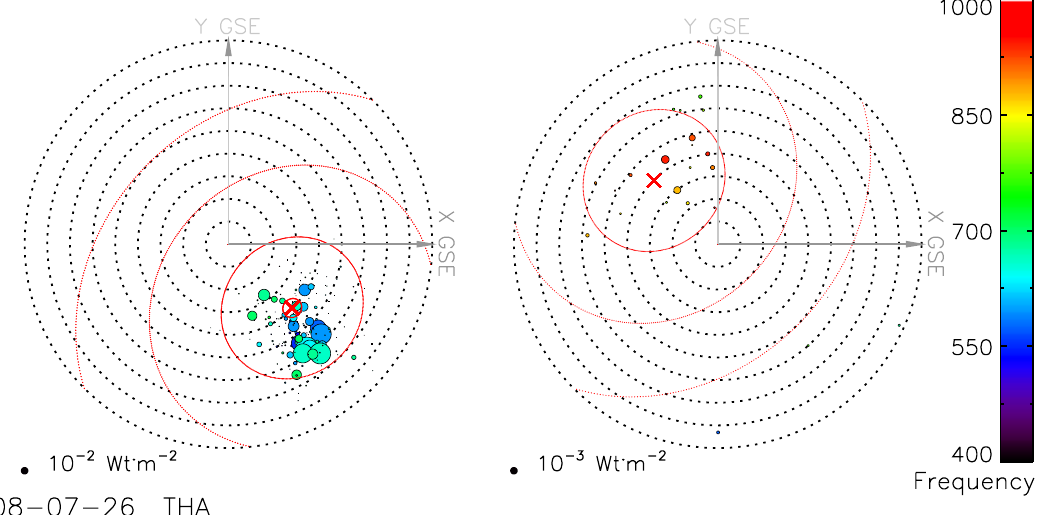
Fig. 4. The Poynting vector directions of the wave packets. The Sun is to the right, and the polar axis is along Z GSM . The background magnetic field direction is indicated by the red cross in the circle. The opposite direction is indicated by the red cross (right). The colors of the circles show the wave frequency according to color bar; the radius of the circles is proportional to the Poynting flux magnitude shown by black